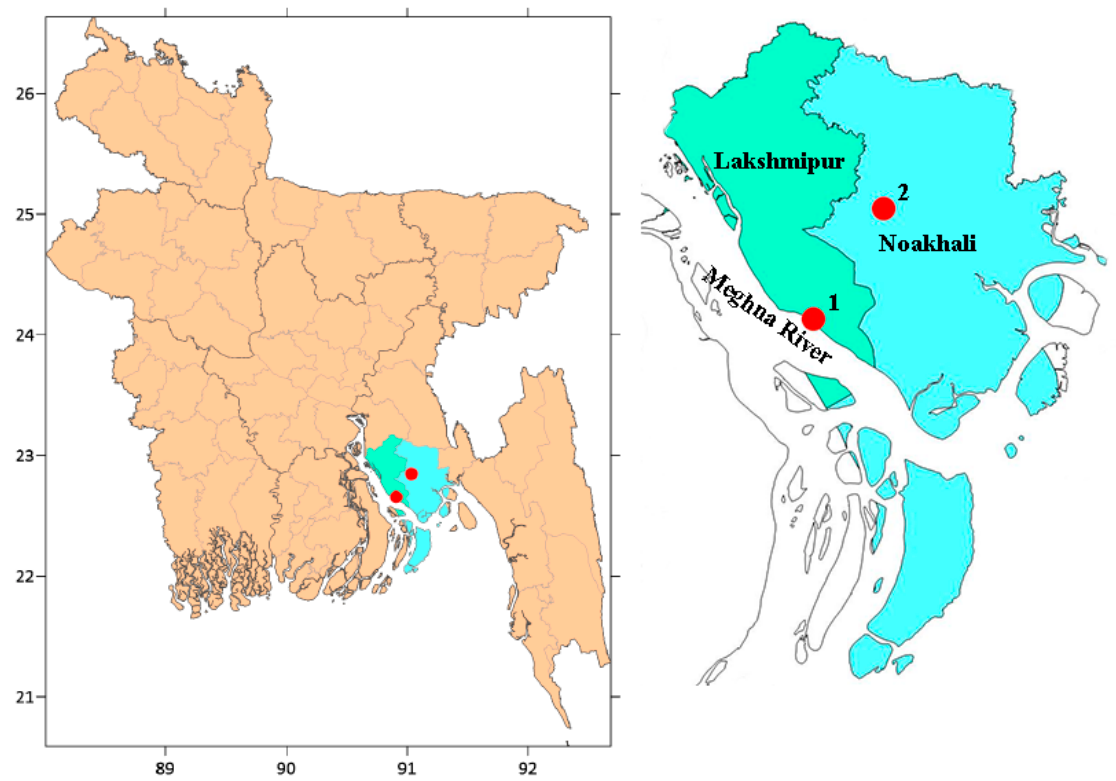
Figure 1. Sampling location of the Wild (site 1) and Cultured (site 2) Barramundi fish in Bangla-